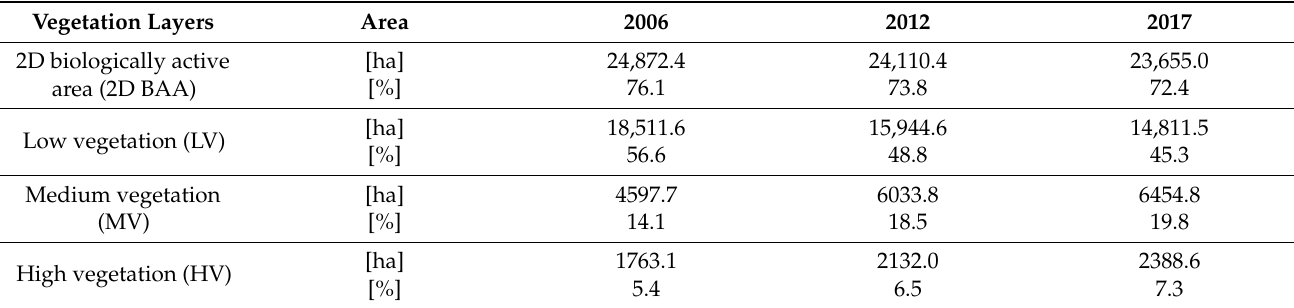
Figure 6. Changes in vegetation area [%] in Krakow according to year. Table 3. Vegetation cover in Krakow for 2006, 2012, and